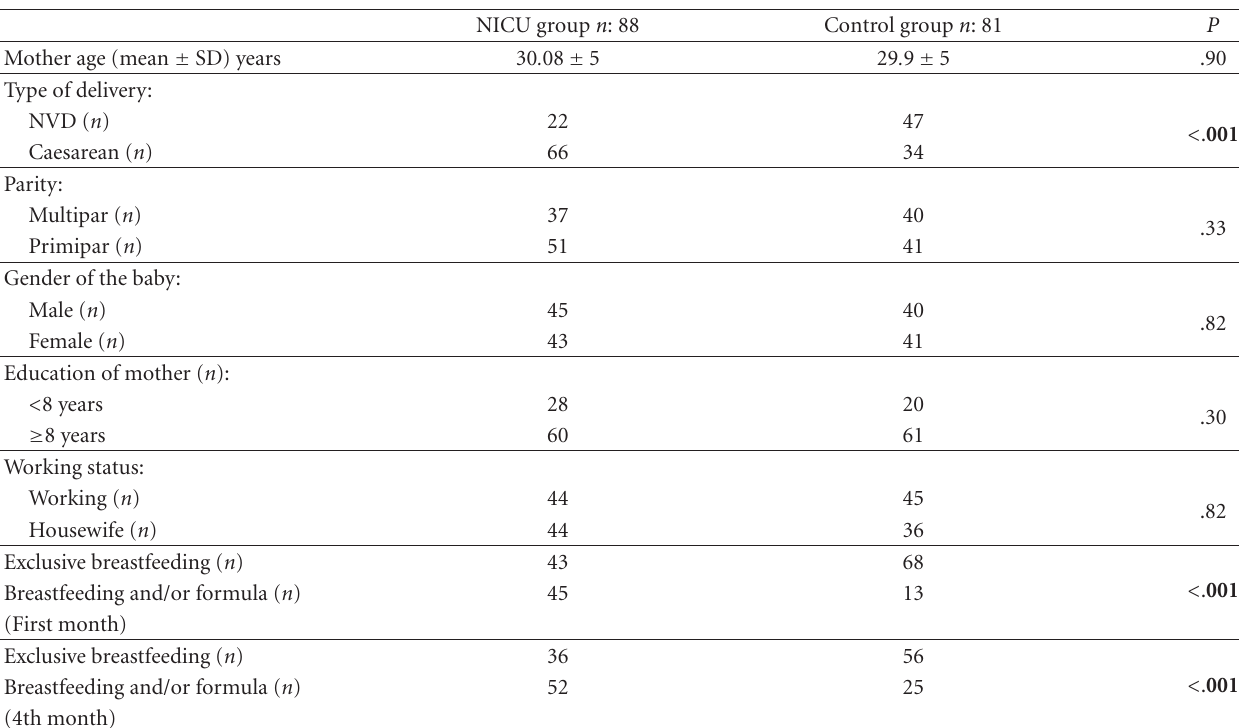
Table 2: Demographic characteristics of the NICU and control groups.